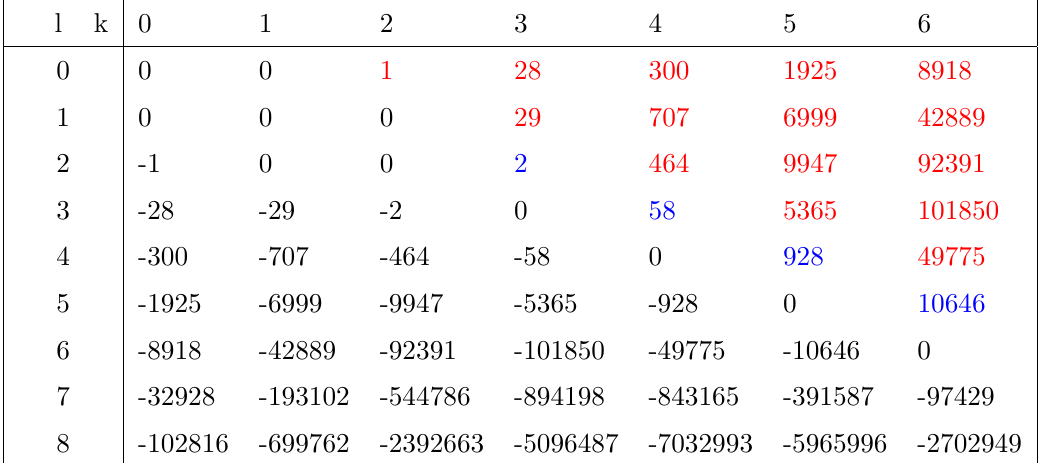
for the elliptic genus of one SO(8) k;l